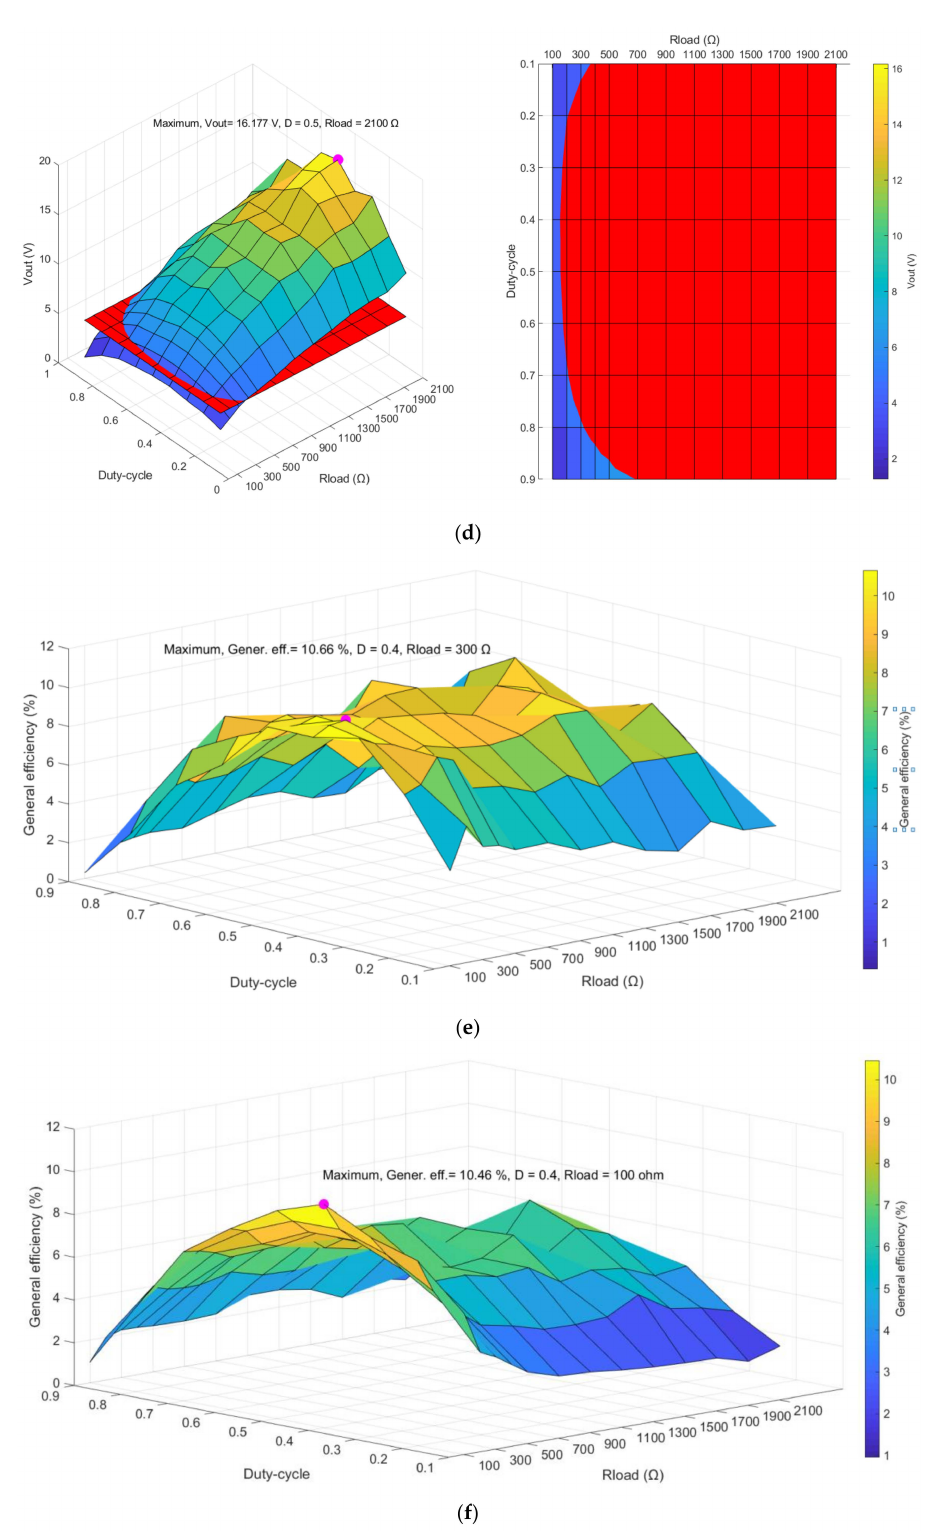
Figure 32. Three phase diode bridge converter simulation results. The ( a , c , e ) figures are with 3 m / s wind velocity and 200 kHz switching frequency. The ( b , d , f ) figures are with 10 m / s wind velocity and 500 kHz switching frequency. ( a ) Output power (3 m / s, 200 kHz). ( b ) Output power (10 m / s; 500 kHz). ( c ) Output voltage (3 m / s, 200 kHz), Red plane: 3 V as minimum. ( d ) Output voltage (10 m / s, 500 kHz), Red plane: 3 V as minimum. ( e ) Generator + Converter e ffi ciency (3 m / s, 200 kHz). ( f ) Generator + Converter e ffi ciency (10 m / s; 500